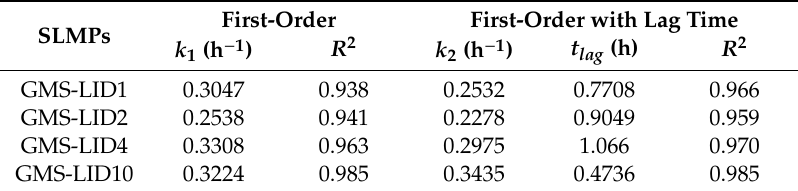
Table 2. Kinetic fitting parameters of LID release profiles from SLMPs in PBS pH 7.4 medium to the first-order and the first-order with lag time kinetic models according to Equations (2) and (3), respectively.